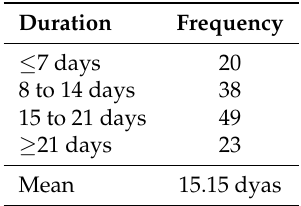
Table 1. Duration of hospital stay of identified patients.